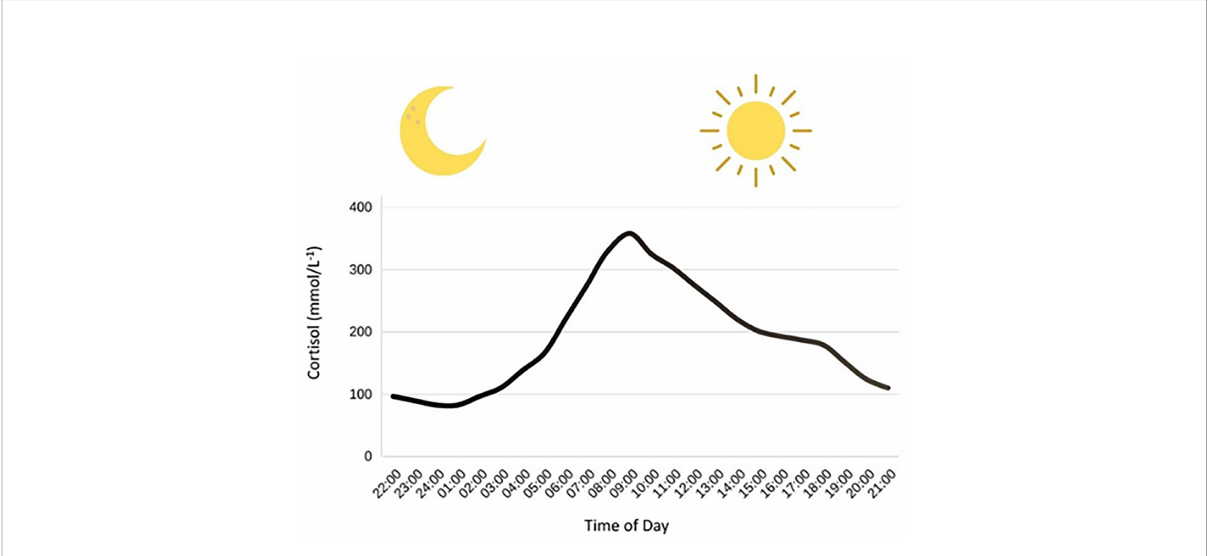
FIGURE 1 Circadian variation in cortisol concentrations. Cortisol has a nadir around (01:00) and then has a steep rise in the morning hours, eventually hitting a peak at around (09:00). After this peak, cortisol concentrations decline throughout the rest of the day. Figure adapted from Debono et al.